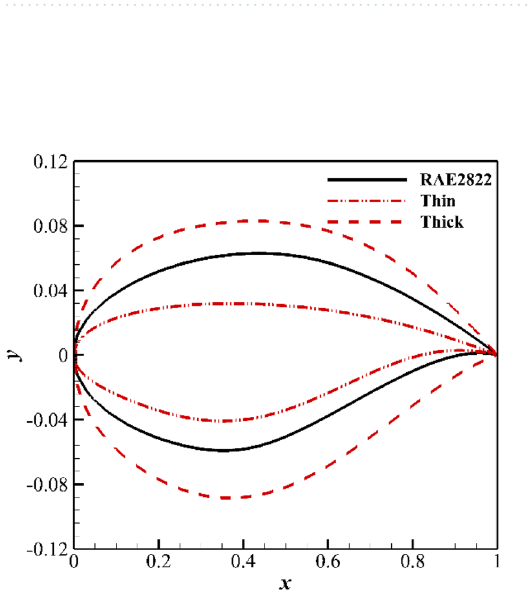
Figure 12. The design space for RAE2822